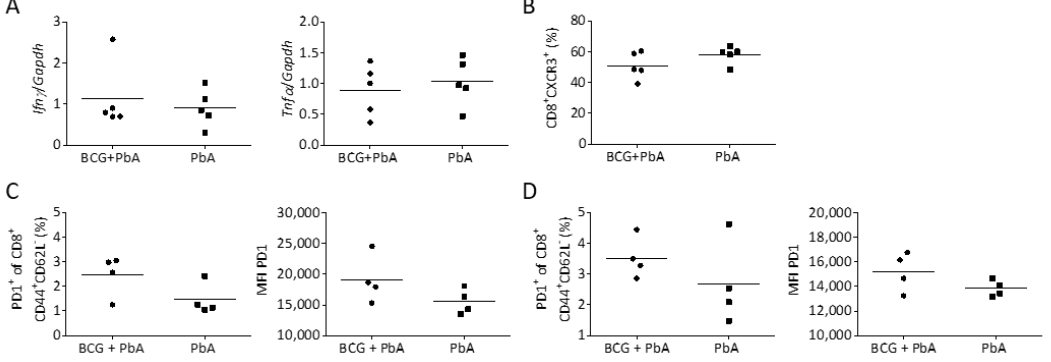
Figure 6. Assessment of immune responses in brain, blood and spleen in response to PbA infection 130 days after BCG vaccination. Mice were vaccinated with BCG or left untreated and challenged with PbA 130 days later. ( A ) Expression of cytokines by qPCR and ( B ) flow cytometric assessment of CXCR3 + CD8 + T cells in the brain on day 8 post PbA infection. ( C , D ) Flow cytometric assessment of the surface expression of PD1 on CD8 + effector T cells in blood ( C ) or spleen ( D ) on day 6 after PbA infection. Symbols and bars represent individual mice and means, respectively. n = 5 ( A , B ) or 4 ( C , D ). Statistical analysis was performed by Student´s t -test.